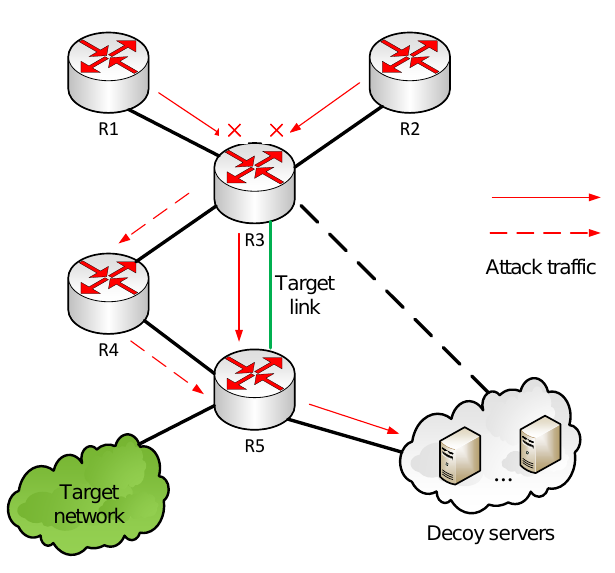
Figure 11. Defending Crossfire Attack